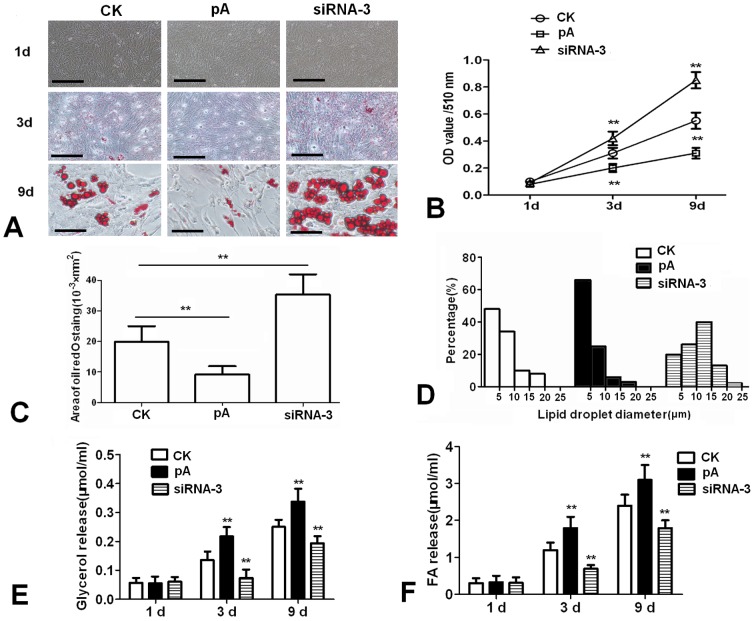
Effects of adiponectin on morphology changes and lipid metabolism of cultured chicken preadipocytes.(A) Representative images of Oil Red O-stained sections of three groups at day 1, 3 and 9. Scale bar, 100 µm. (B) Lipid accumulation was assessed by the quantification of A510 in destained Oil Red O with isopropyl alcohol (n = 3). (C) The areas stained with Oil Red O assessed (n = 3). (D) Lipid droplet diameter frequency distributions for the three groups. Numbers on the x-axis represent the bins for droplets of specific sizes. (E) Glycerol content in the medium (n = 3). (F) FFA content in the cell culture medium (n = 3). FFA: free fatty acid, CK: Control group, pA: pcDNA3.1-ADPN, siRNA-3: pGPU6/GFP/Neo-ADPN-952. Values are means ± SEM. vs. control group, * P<0.05, ** P<0.01.